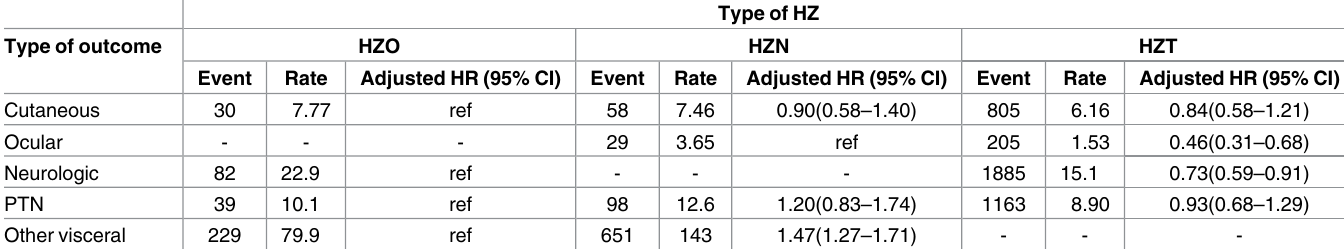
Table 2. Adjusted hazard ratios (95% confidence interval) for herpes zoster complication risk. Adjusted HR: Adjusted for age, sex, CAD, hyperten- sion, hyperlipidemia, DM, stroke, AF, renal disease, heart failure, cancer, chronic hepatitis, and SLE. Abbreviations: CAD: coronary artery disease; DM: dia- betes mellitus; AF: atrial fibrillation; SLE: systemic lupus erythematosus; Rate: incidence, per 1000 person-years; PTN: primary trigeminalneuralgia. Type of